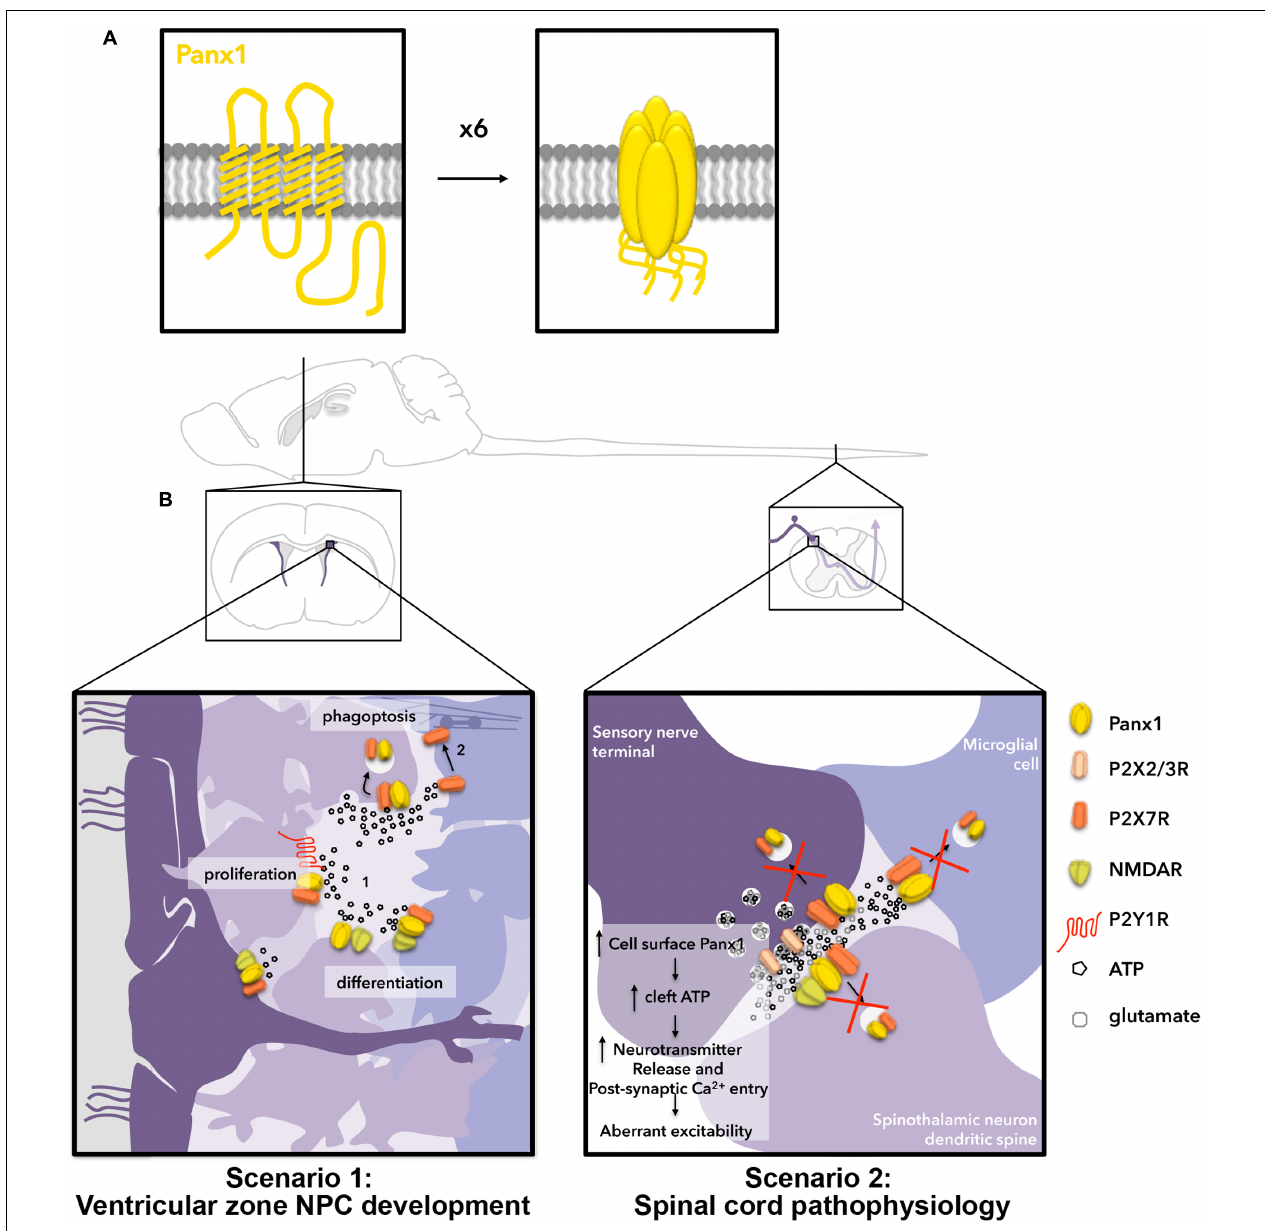
FIGURE 1 | Hypothetical outcomes for two scenarios related to ATP-stimulated internalization of Panx1 channels in the nervous system. (A) Panx1 channels (yellow) are formed by hexamers of 4-transmembrane domain Panx1 subunits. (B) Two scenarios in which we hypothesize ATP-dependent Panx1 internalization are relevant for nervous system function. Scenario 1 (left) occurs in the postnatal ventricular zone. In the ventricular zone, neural stem cell-like radial glia (dark purple), give rise to rapidly proliferating transit-amplifying NPCs (light purple), which further give rise to neuronal-specific migratory neuroblasts (bluish-purple; left to right). Here, ATP is released by exocytosis and through channels to promote proliferation of transit-amplifying NPCs by activating P2Y1Rs, and to negatively regulate neuronal differentiation/survival by activating P2X7Rs. We have also shown the ATP-release channel Panx1 positively regulates proliferation/maintenance and negatively regulates differentiation (neurite outgrowth) of these cells. NMDARs are also present on radial glia, transit-amplifying NPCs, and neuroblasts, and have been shown to regulate proliferation and differentiation in the ventricular zone. When ATP levels surpass the threshold for internalization, we propose this triggers Panx1 internalization, resulting in reduced proliferation signaling through P2Y1Rs, increased neurite outgrowth (perhaps in part by decreasing P2X7R signaling) and increased phagoptosis by phagocytic neuroblasts. Scenario 2 (right) occurs in the spinal cord. Here, ATP is co-released with glutamate at synapses and is also released from astrocytes (not depicted) and microglia. We propose that ATP-induced Panx1 internalization normally regulates the concentration of ATP in the synapse. We posit that pathological changes to membrane lipid microdomains result in impairment of ATP-mediated endocytosis of Panx1 thereby augmenting Panx1 surface expression and ATP release, resulting in aberrant excitability and leading to the development of chronic pain and opioid withdrawal symptoms.